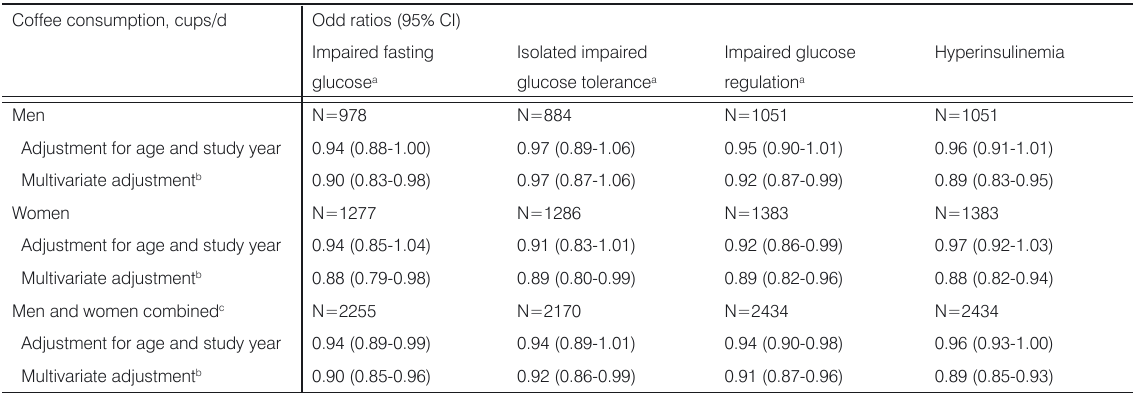
a Using normal glucose tolerance, fasting glucose <110 mg/dl and 2-hour glucose <140 mg/dl as reference group in the analysis of hyperglycaemia; impaired fasting glucose, fasting glucose 110-125 mg/dl; isolated impaired glucose tolerance, 2-hour glucose 140-199 mg/dl and fasting glucose <110 mg/dl; impaired glucose regulation, fasting glucose 110-125 mg/dl and/or 2-hour glucose 140-199 mg/dl; hyperinsulinemia; sex- and study year-specific quartile 4 of fasting insulin. b Adjusted for age, study year, body mass index, systolic blood pressure, education, occupational and leisure time physical activity, walking or cycling to/from work, cigarette smoking, alcohol and tea consumption. c Adjusted also for